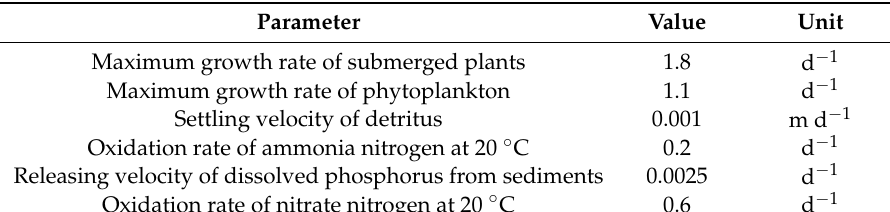
Table 4. Key calibration coefficients used for the EcoTaihu model application.